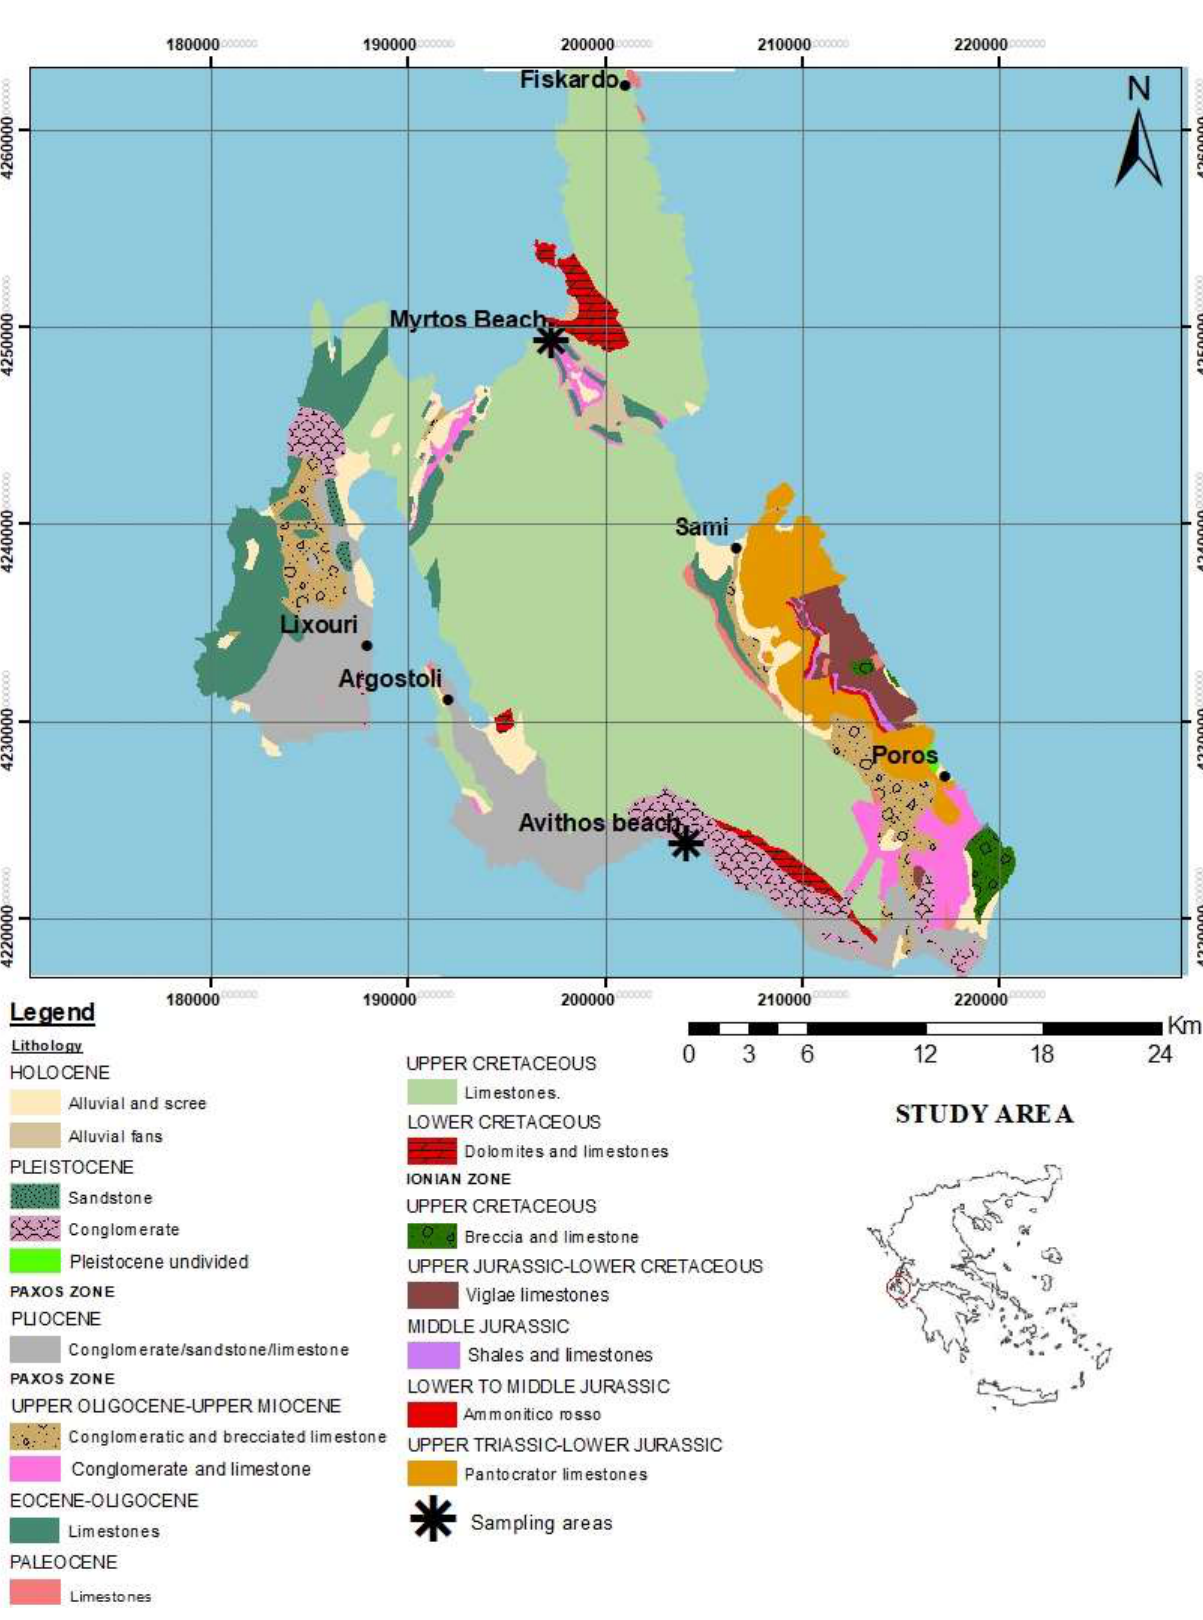
Figure 1. Geological map of Kefalonia, modified after [26].